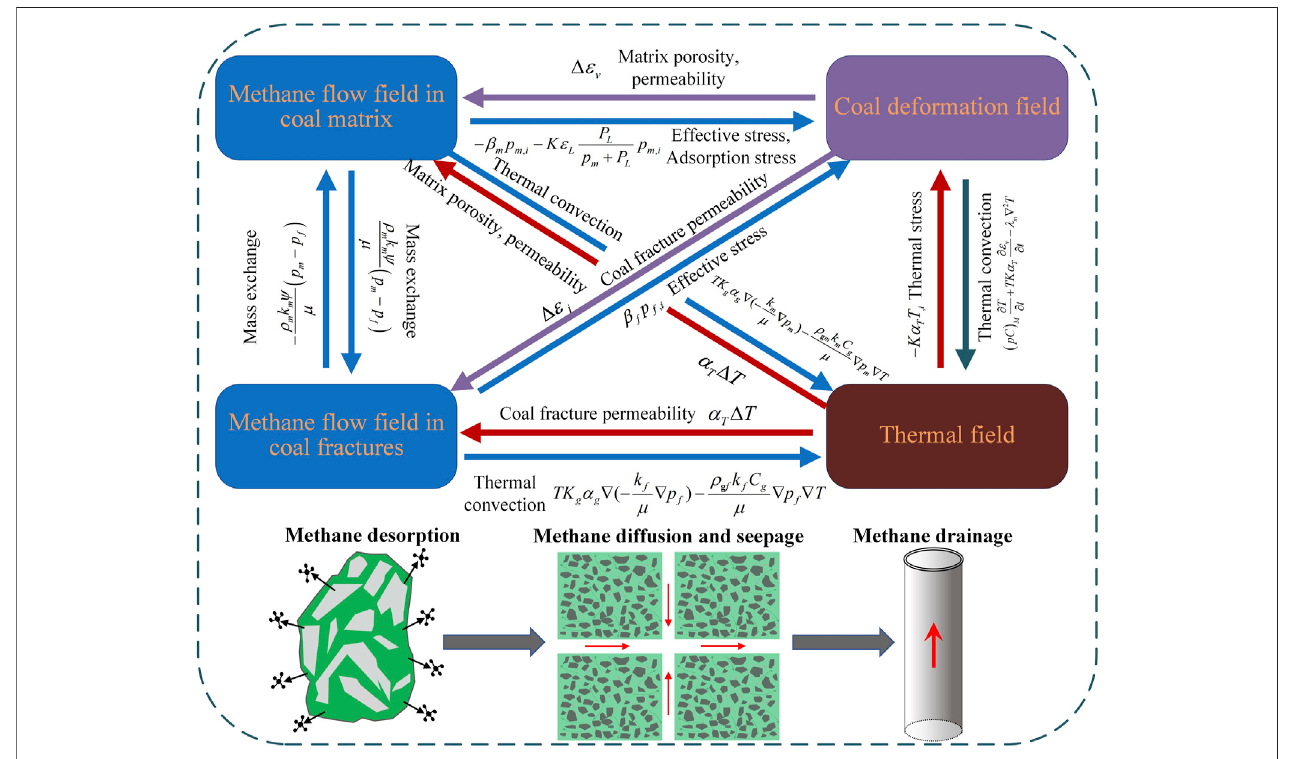
FIGURE 2 | Diagram illustrating the interactons and cross-coupling relationships simulated by the THM coal seam gas drainage model.